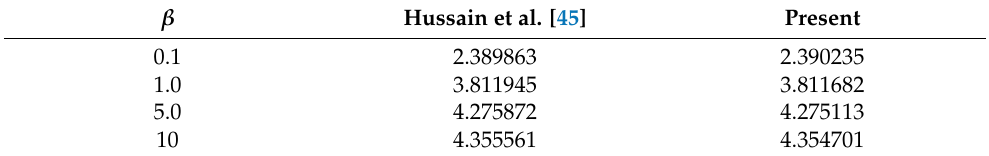
Table 3. Comparison of results with the published work of Hussain et al. [45] for various values of β . β Hussain et al. [45] Present